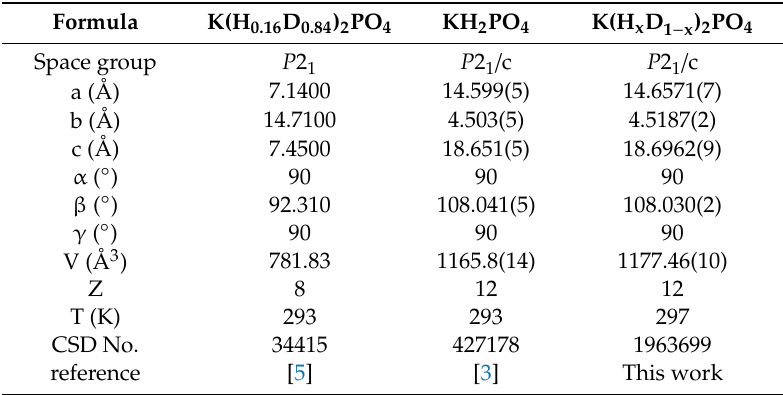
Table 1. Basic crystallographic data comparison of the monoclinic DKDP bulk crystal, monoclinic DKDP, and KDP single-crystalline fibers.